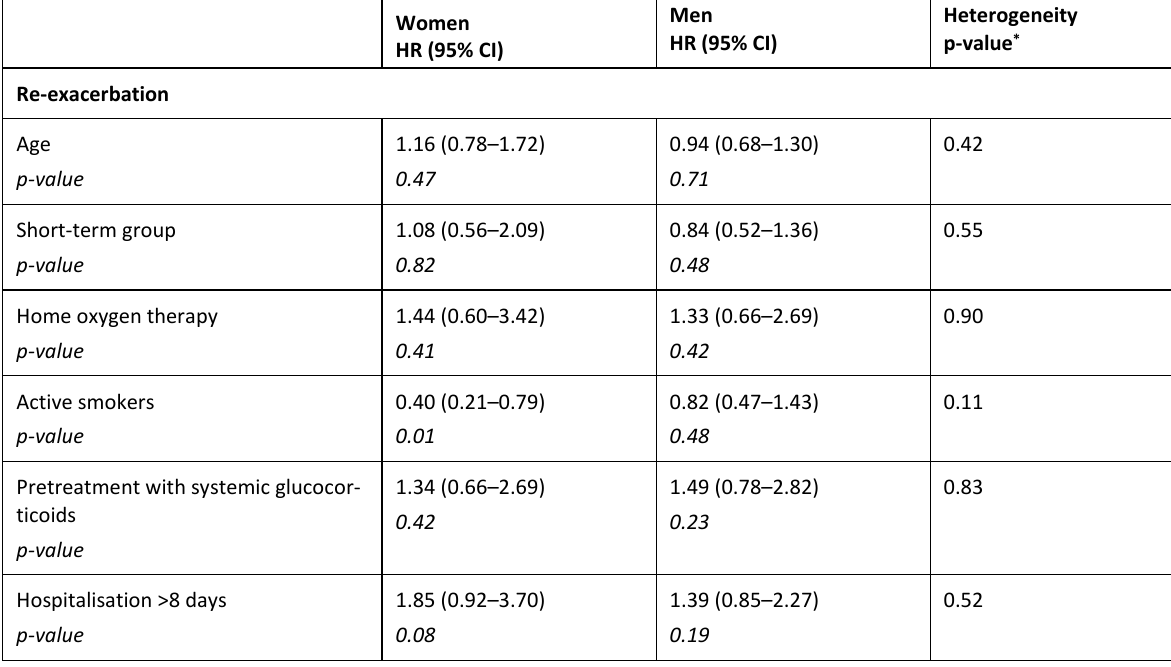
Table S4A: Multivariate analysis of time to re-exacerbation or re-exacerbation and/or death stratified by